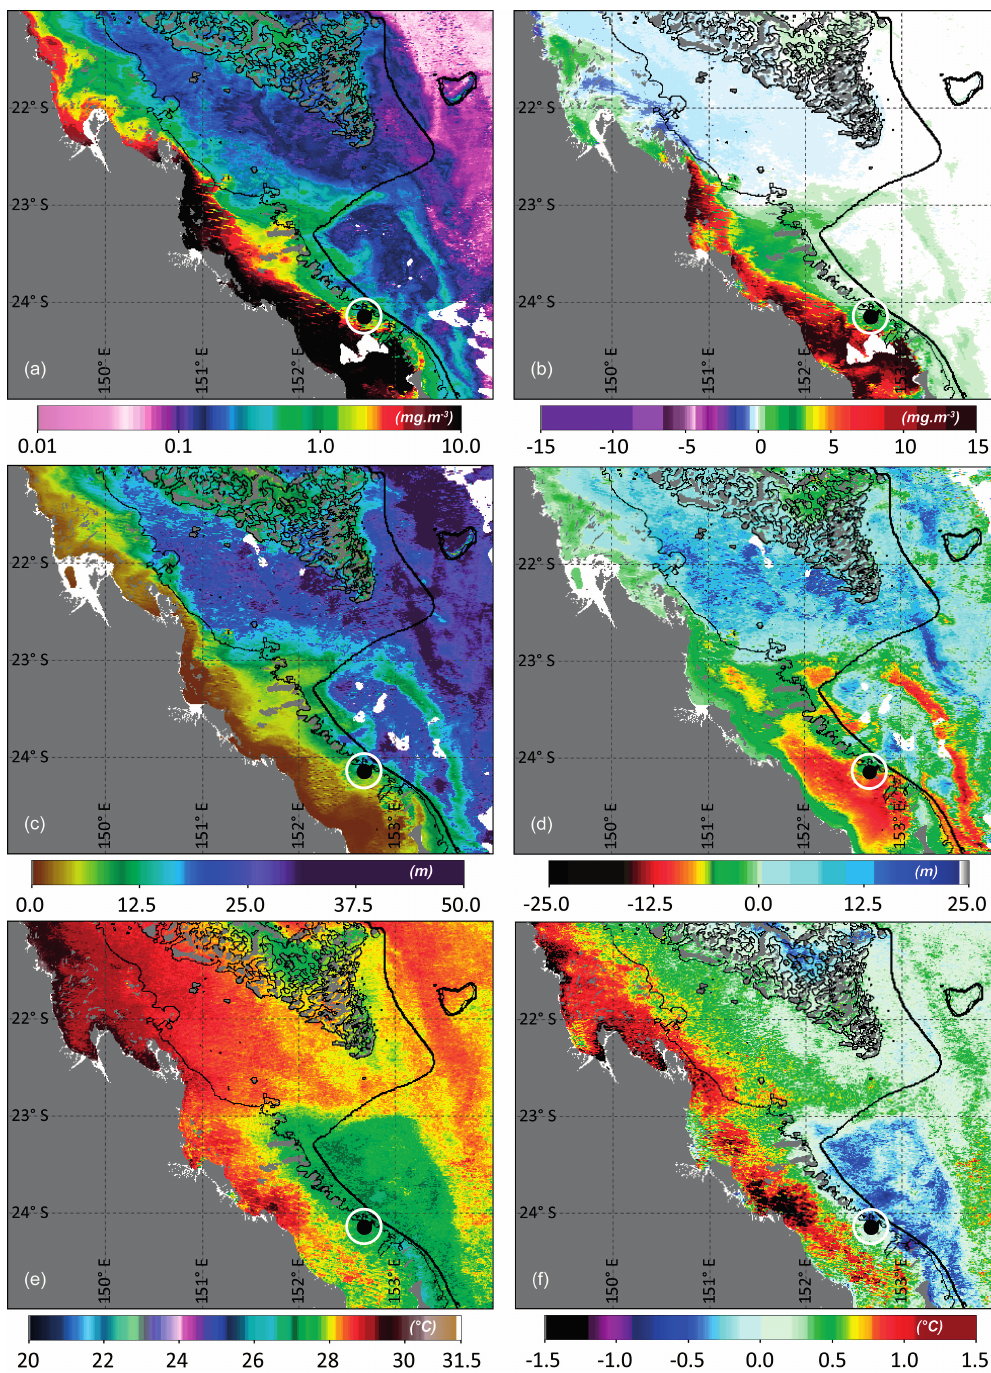
Figure 4. MODIS chlorophyll- a (mg·m − 3 ), photic depth (m) and SST ( ° C) images for the southern GBR (21 ° S–25 ° S; 149 ° E–154 ° E) for 2 to 4 February 2013. Anomalies are relative to respective February decadal (2002–2012) climatologies. ( a ) Chlorophyll; ( b ) chlorophyll anomalies; ( c ) photic depth; ( d ) photic depth anomalies; ( e ) SST and ( f ) SST anomalies. The black circular marker with white ring shows the location of Lady Elliot Island. The 50 m (thin black) and 200 m (thick black) isobath lines are overlain. Time series of nine months of temperature data from the loggers on the OTE mooring indicated frequent bottom water temperature fluctuations near the shelf break (Figure 5a). While near